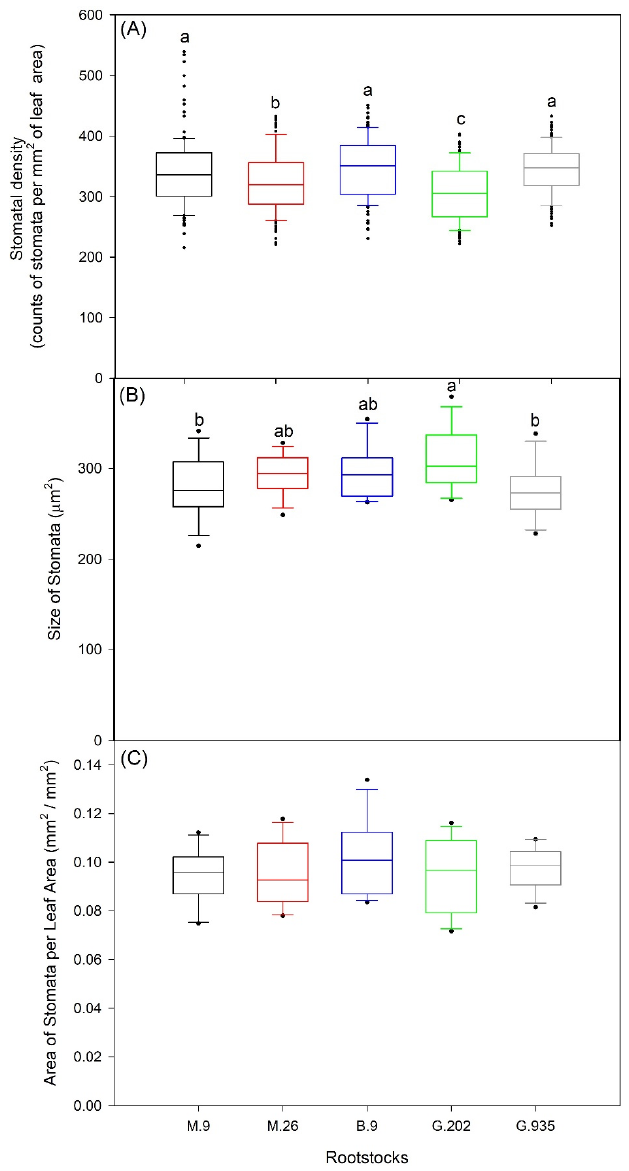
Figure 3. Stomatal density ( A ), average size of stomata ( B ), and stomatal area per leaf area of apple leaves ( C ) of Ambrosia TM scion on five rootstocks in the greenhouse water deficit experiment. Different letters in each sub-panel stand for significant differences amongst rootstocks ( P ≤ 0.05, ANOVA, Fisher LSD pairwise comparisons) ( n = 6, each replication consists of 20 imprints, i.e., 5 from each of 4 leaves). The absence of letters means that there were no significant differences.